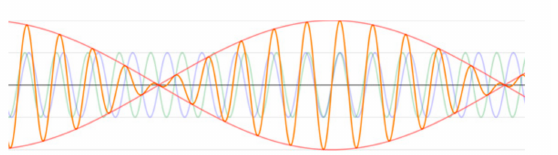
Figure 1. The superposition of two sine waves with similar frequencies f 1 and f 2 (blue and green) linearly causes an interference frequency sinusoid at the sum frequency (f 1 + f 2 )/2 10 (orange) and another sinusoid which is the envelope of (f 1 + f 2 )/2 modulated at difference frequency (f 1 − f 2 )/2. The Fourier transform contains only the two frequencies f 1 and f 2 . Picture taken from [31].